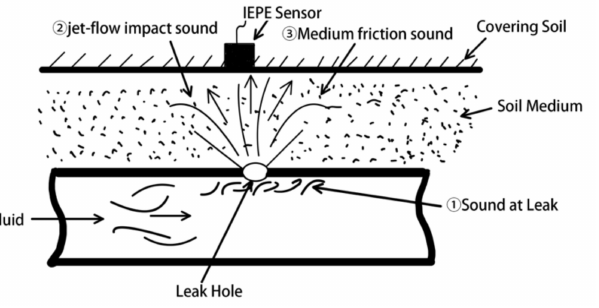
Figure 1. Schematic of the generation of acoustic emission signals from a pipeline